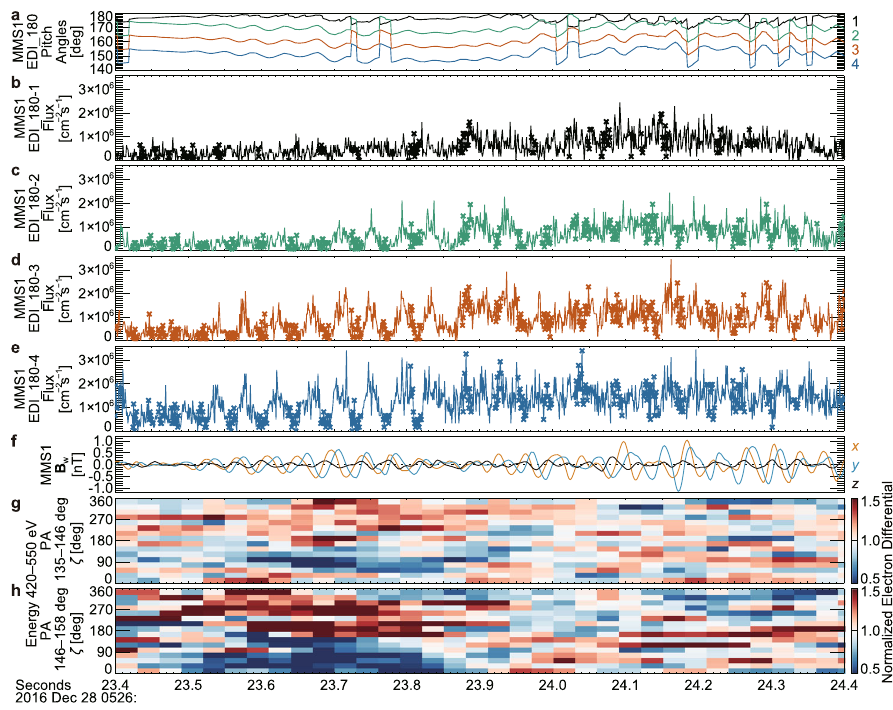
Fig. 7 | Modulation of electron fl ux (Event 2). The format is the same as that of Fig. 5. Both measurements by Fast Plasma Investigation-Dual Electron Spectro- meters and EDI_180 indicate the existence of a dip of electron fl uxes at ζ of about 90° around V res . When B w was about 0.5 nT, electrons around 500eV exhibited